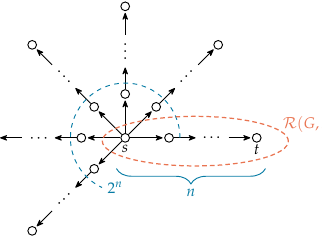
Figure 3. A directed spider with 2 n legs each of length n that could be the auxiliary graph of a ( G , k ) . Assume s is the start configuration and, graph searching game – i.e., the vertex set is B ( G , k ) contains only n for the sake of argument, that t is the sole winning configuration. Then R elements, while the whole game has 2 n n configurations. · the whole game has 2 n n ·